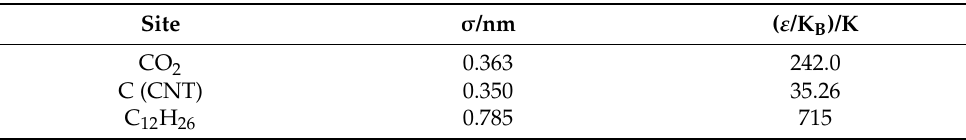
Table 1. L-J potential energy of each molecule used in this